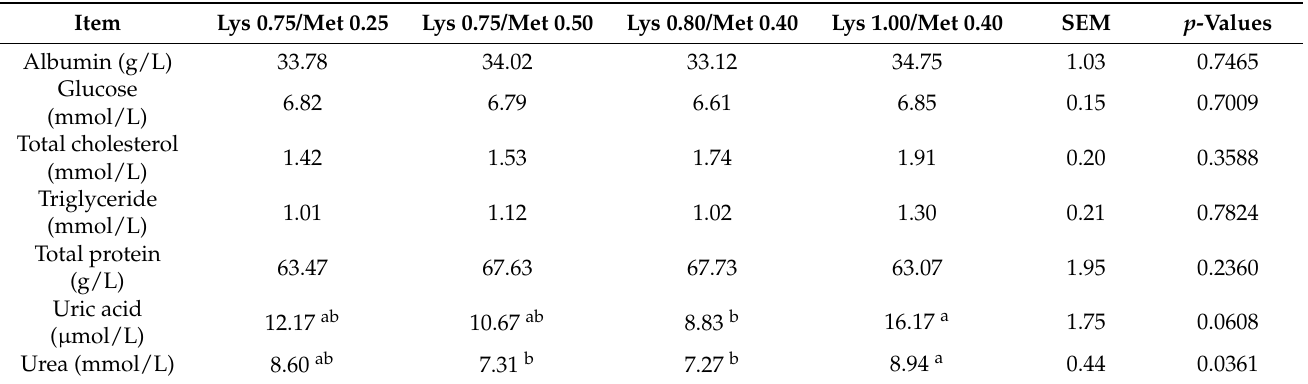
Table 3. Effect of different lysine and methionine composition in diets on blood biochemical indices in rabbits ( n =